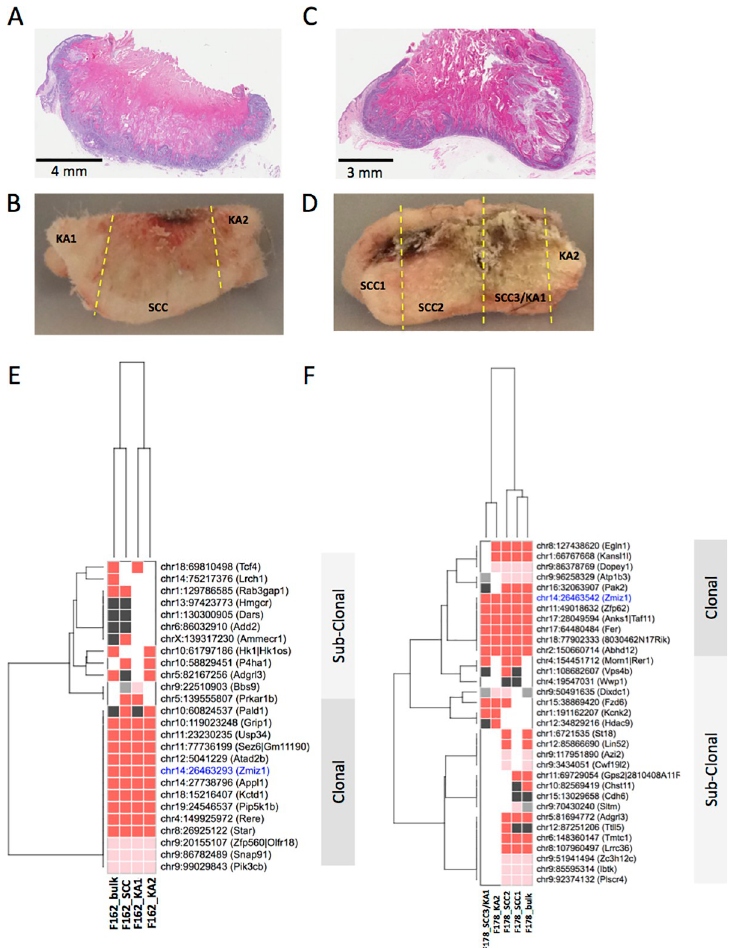
Fig 3. Multi-region SBCapSeq analysis of dual histology keratinocyte-derived skin masses containing distinct cuKA and cuSCC histological regions. Two individual mice displayed lesions with both cuKA and cuSCC histologies suggestive of clonal evolution of cuSCC differentiation within cuKA masses. Aperio slide scans of H&E stained FFPE specimens and the adjacent flash frozen tissue for specimen 1 ( A-B ) and specimen 2 ( C-D ) prior to sectioning for genomic DNA isolation. Yellow dotted lines demarcate the distinct lesions within each section that were sampled for sequencing SB insertions. Hierarchical two-dimensional clustering (Hamming distance with the Ward method) of recurrent genic SBCapSeq insertion data for specimen 1 ( E ) and specimen 2 ( F ) demonstrates trunk (common to all samples) and sub-clonal, lesion-specific SB insertions ( S4 Data ). Genomic DNA was isolated from adjacent serial sections and included a “bulk” reference consisting of a cross-section of entire mass, and three or four regions dissected from histologically distinct regions.